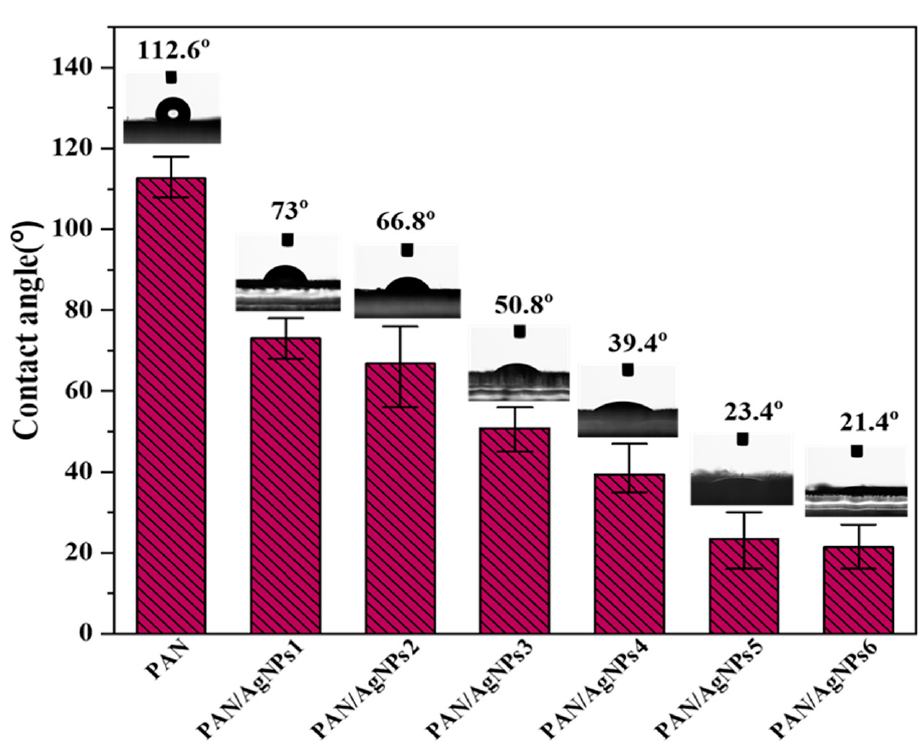
Figure 6. Water contact angle (WCA) of PAN nanofiber, PAN/AgNPs1, PAN/AgNPs2, PAN/AgNPs3, PAN/AgNPs4, PAN/AgNPs5, and PAN/AgNPs6.